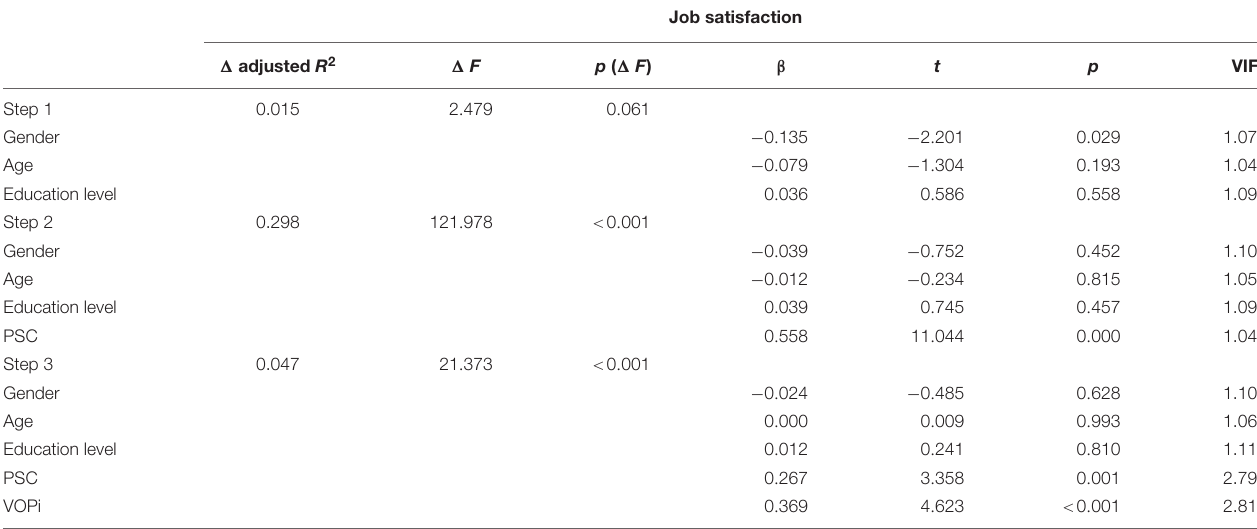
TABLE 7 | Incremental validity of VOPi on job satisfaction.